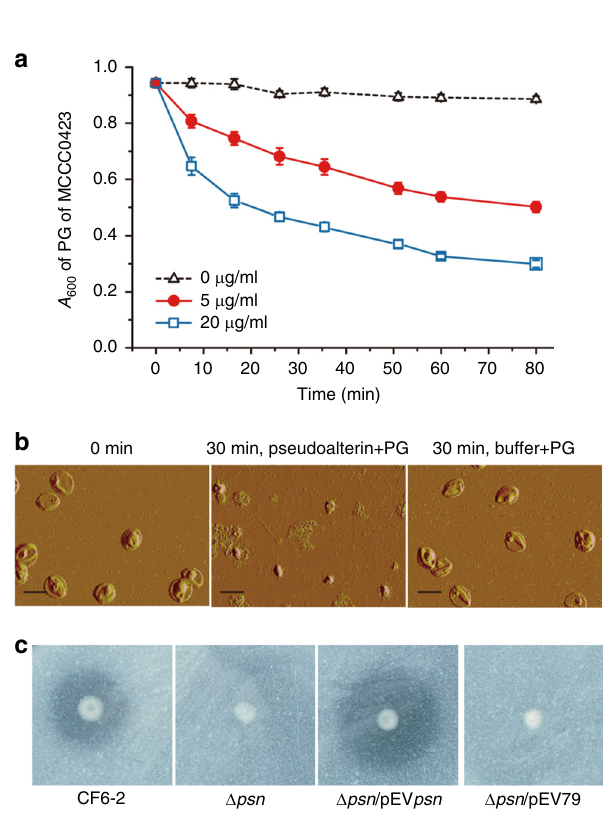
Fig. 3 PG degradation by pseudoalterin. a Degradation curves of pseudoalterin towards PG of strain MCCC0423 at 25 °C. b AFM observation of the degradation of PG of strain MCCC0423 by pseudoalterin. Control, PG of strain MCCC0423 treated with buffer for 30 min. Bars: 1 μ m. c PG degradation by the mutant strain Δ psn and the complementary strain Δ psn /pEV psn on PG-containing plates. Strains CF6- 2, Δ psn , and Δ psn /pEV psn were spotted and grew on plates containing the PG from strain MCCC0423 at 20 °C for 3 days until clear zones formed around the colonies of strains CF6-2 and Δ psn /pEV psn . The error bar represents standard deviation of triplicate experiments. Each picture is a representative of triplicate experiments. Source data are provided as a Source Data fi